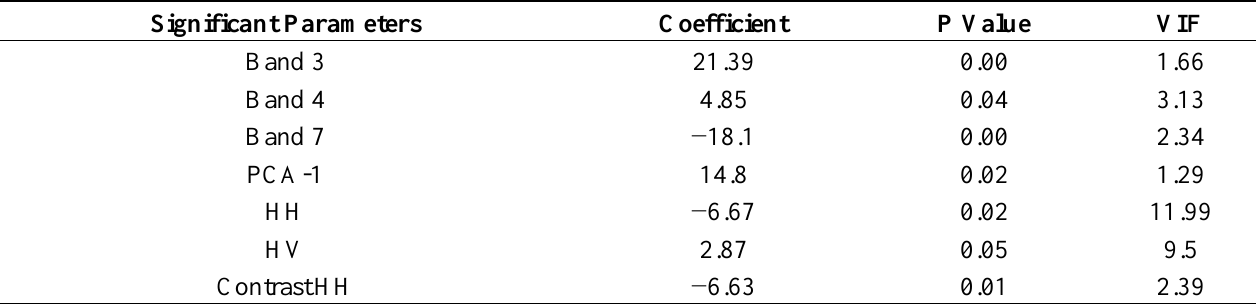
Table 9. Statistics summary of final forest AGB